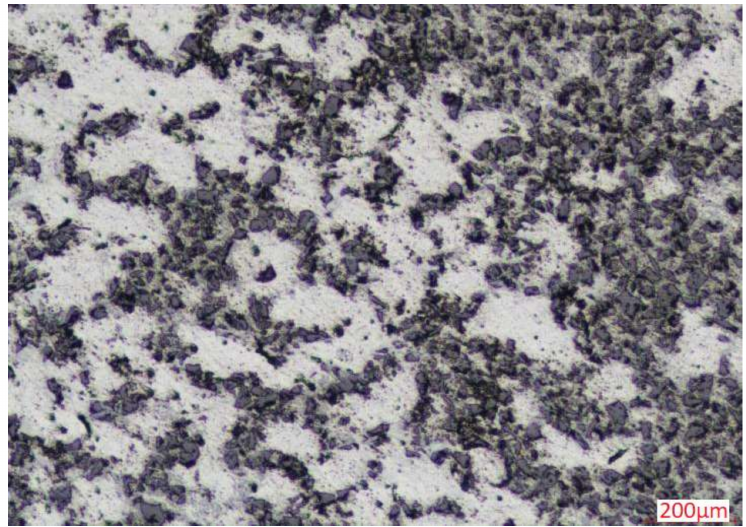
Figure 7. Photomicrograph of the core microstructure of Disc 1 (TS02).